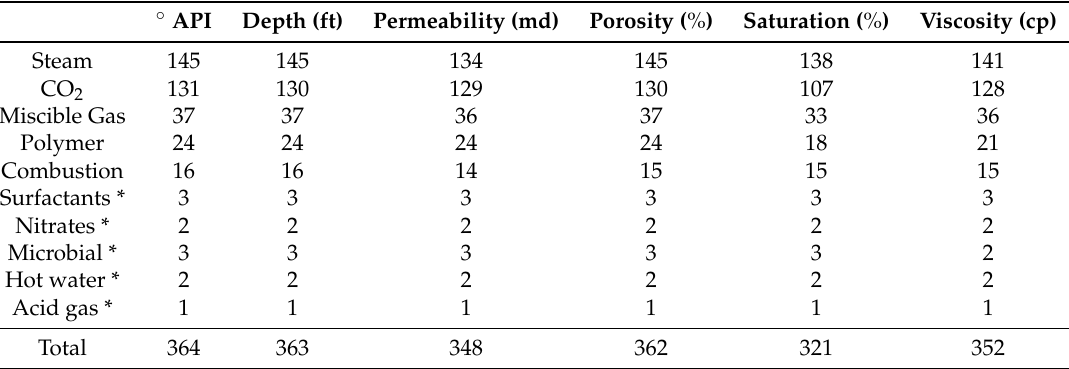
Table 5. Worldwide successful EOR data base by variables. Data source: